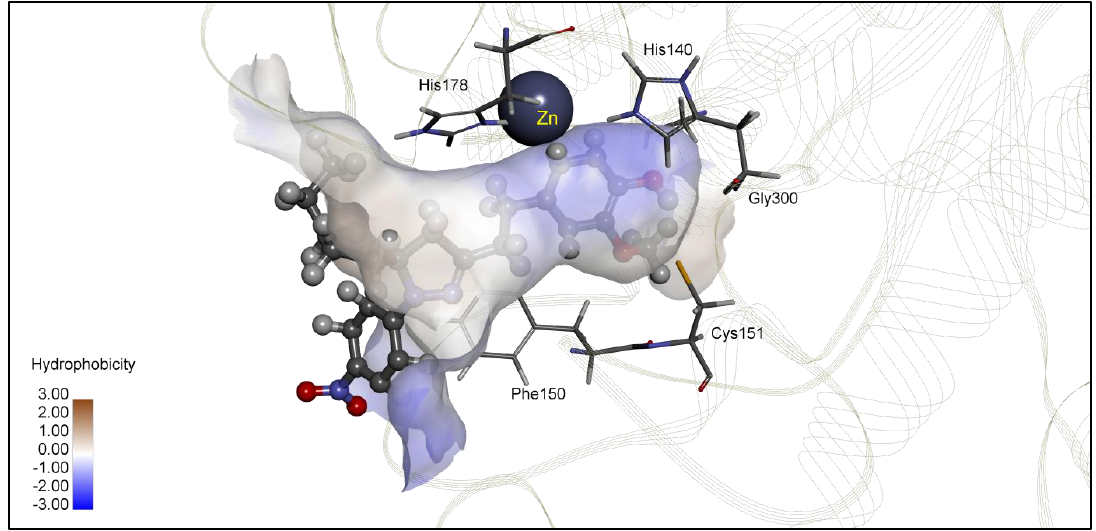
Figure 5. The interaction mode of 5j in the active site of HDAC1.